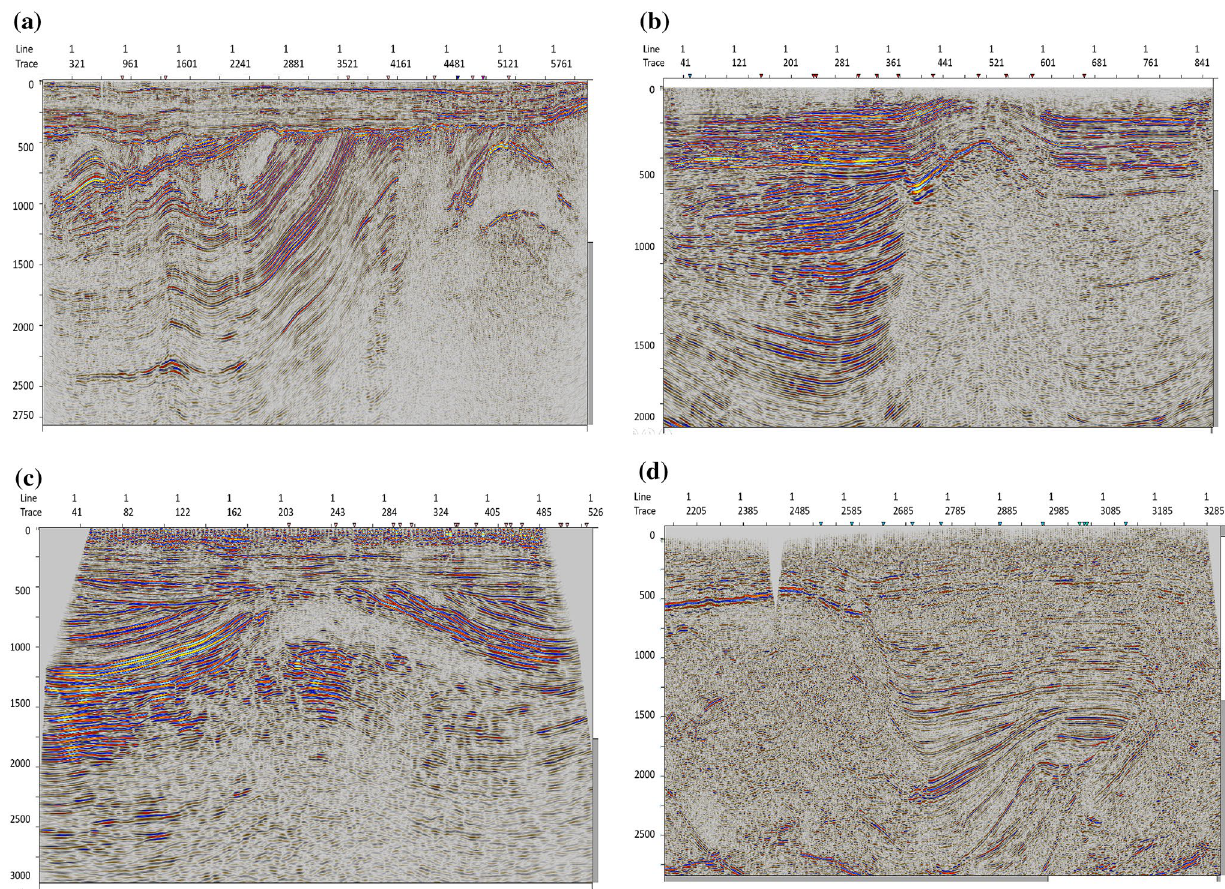
Fig. 6 Trap types: a unconformity; b anticline or dome; c pinchout; d up-dip